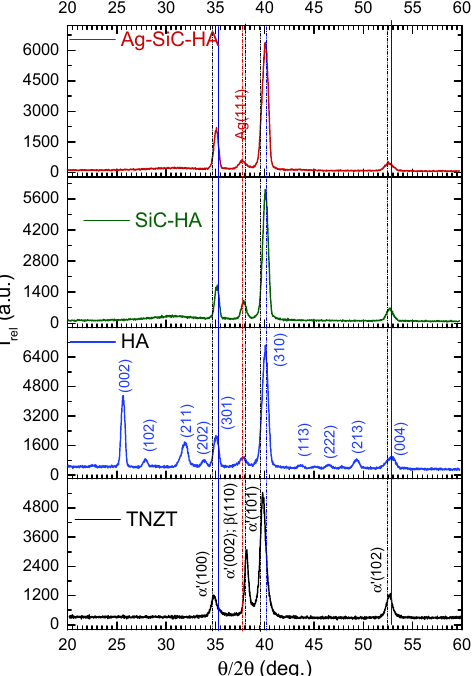
Figure 3. Diffraction patterns of the bare and coated Ti–10Nb–10Zr–5Ta alloy. The following JCPDS cards were used to identify the lines of the coatings and substrate: 055–0592 for HA (hexagonal structure, space group P63/m(176)), 04–0783 for Ag (face centered cubic close-packed structure, space group Fm-3m(225)) and 05–0565 for Si (face centered diamond cubic structure, space group Fd-3m(227)). All four peaks of the TNZT substrate are situated in the proximity of either HA or Ag peaks, as follows: α ’(100) − 34.62 0 is situated in between HA(300)—32.91° and HA(301)—35.481°, α ’(002) and β (110)—38.00° are situated near Ag(111)—38.18°, α ’(101)—39.62° is situated near HA(310)—39.82°, and α ’(102)—52.56° is located in close proximity to HA(004)—53.19°.